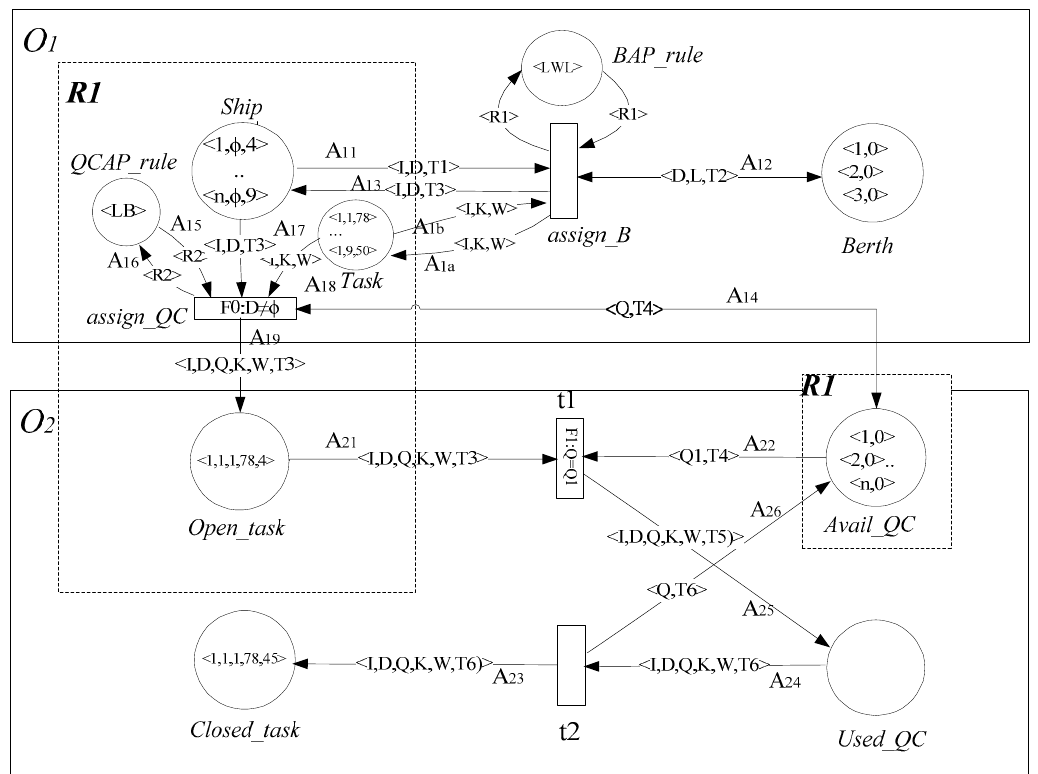
Figure 2. The OOTPr/Tr net model for the three ‐ level framework.